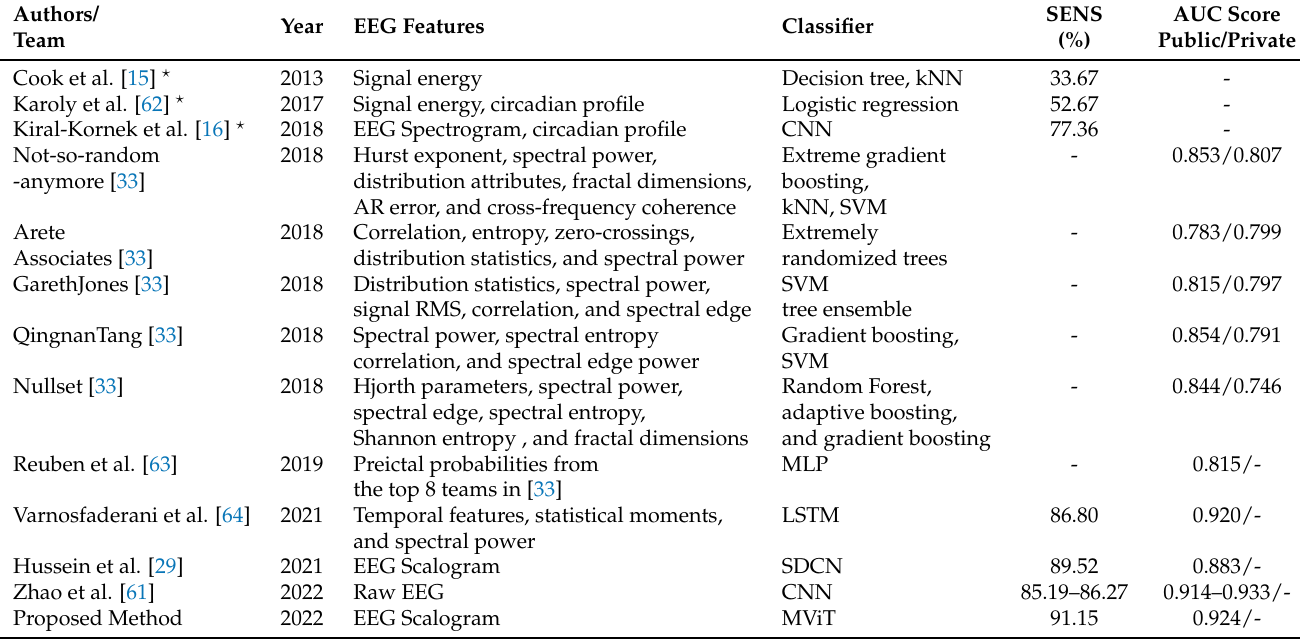
Table 3. Benchmarking of the previous seizure-prediction methods and our MViT approach: Mel- bourne University AES/MathWorks/NIH Seizure Prediction